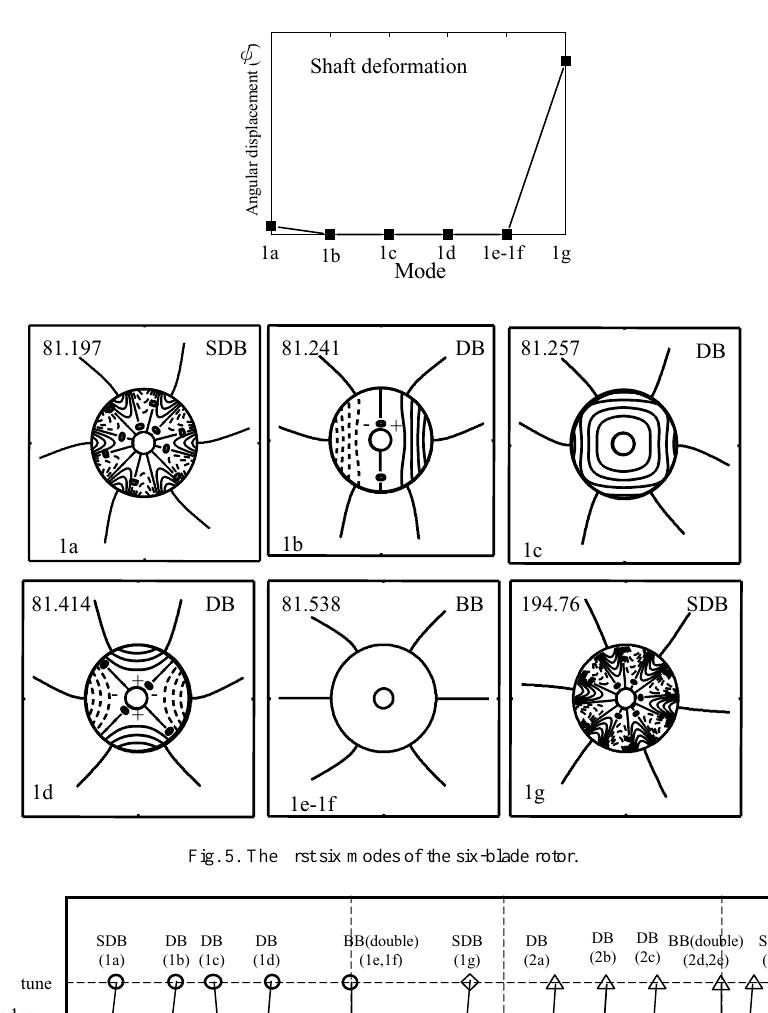
Fig. 5. The first six modes of the six-blade rotor.